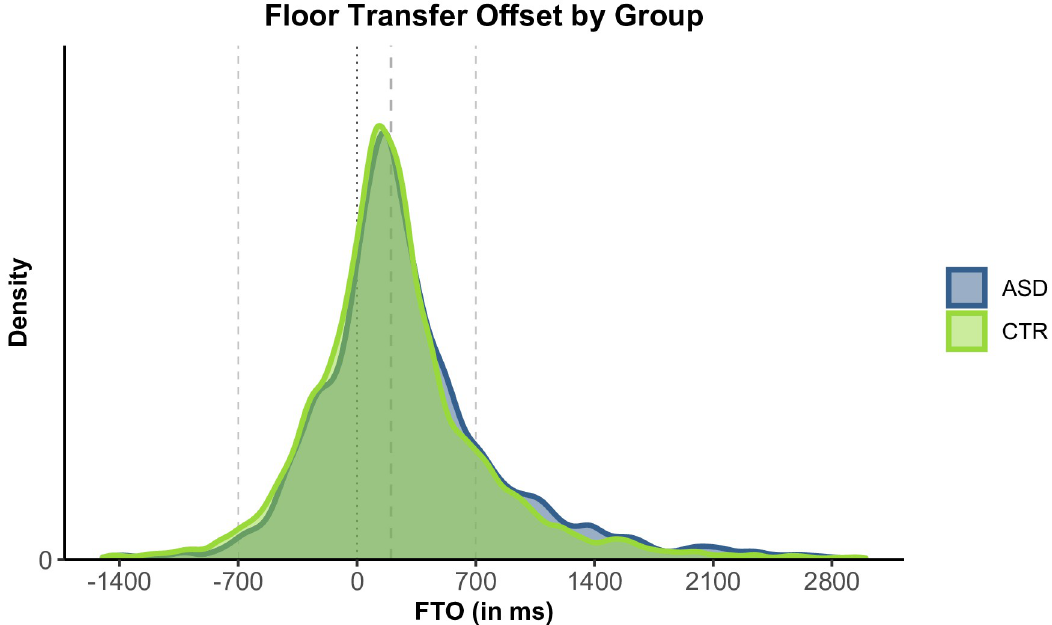
Fig 4. Floor Transfer Offset (FTO) values by group. Positive values represent gaps; negative values represent overlaps. ASD group in blue, CTR group in green. The dotted line indicates the value of 0 ms FTO, representing no-gap-no-overlap transitions. Dashed lines indicate the values of +200 ms (expected for typical transitions) and +/-700 ms FTO (unusually long transitions).